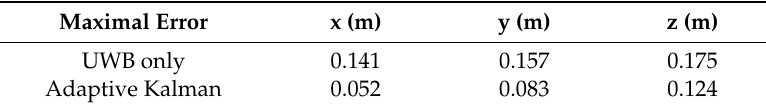
Table 3. Maximum errors of different